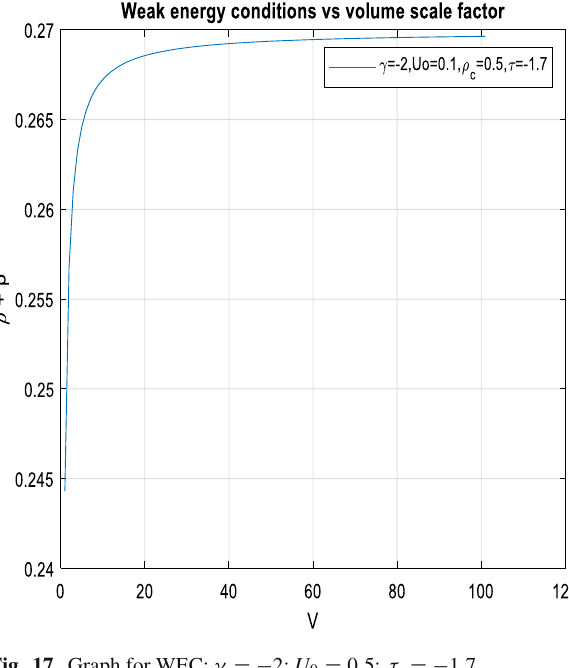
, U = 0 . 1 and τ = − 5 0 8